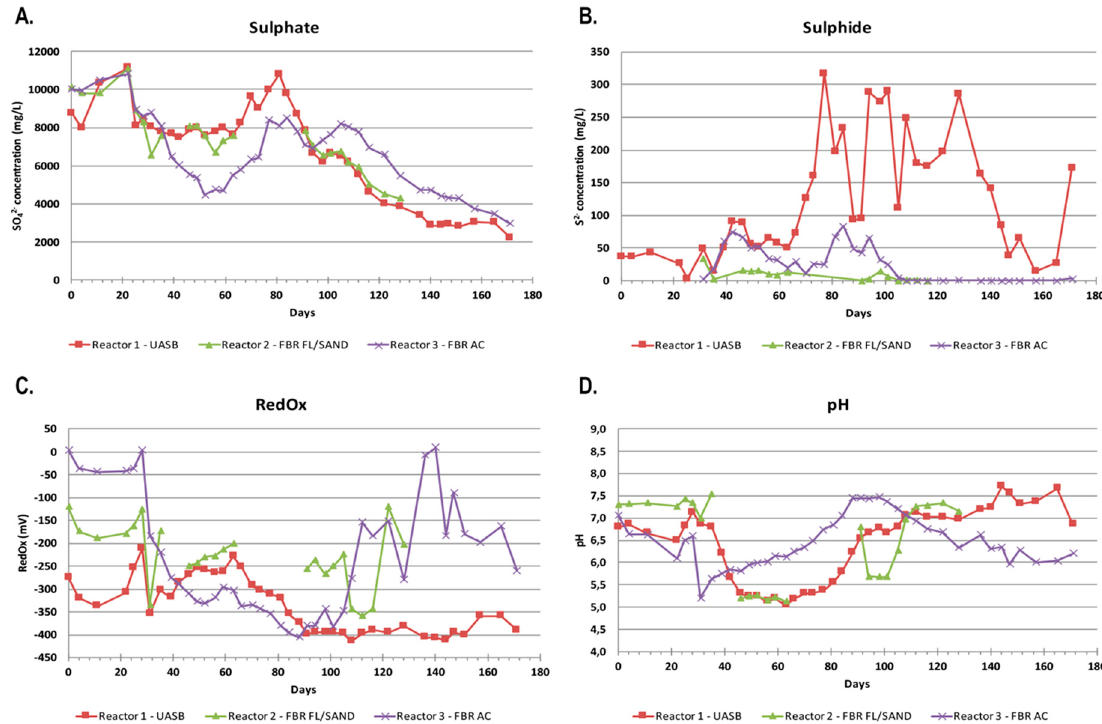
Figure 1. Parameters measured in the effluent of the bioreactors over time: ( A ) the concentration of sulfate (mg L − 1 ); ( B ) the concentration of sulfide (mg L − 1 ); ( C ) the redox potential (mV); and ( D ) the pH over the span of the experiment. The red, green, and purple curves correspond to Reactor 1, Reactor 2, and Reactor 3, respectively. Table 2. Physicochemical parameters of the effluents on day